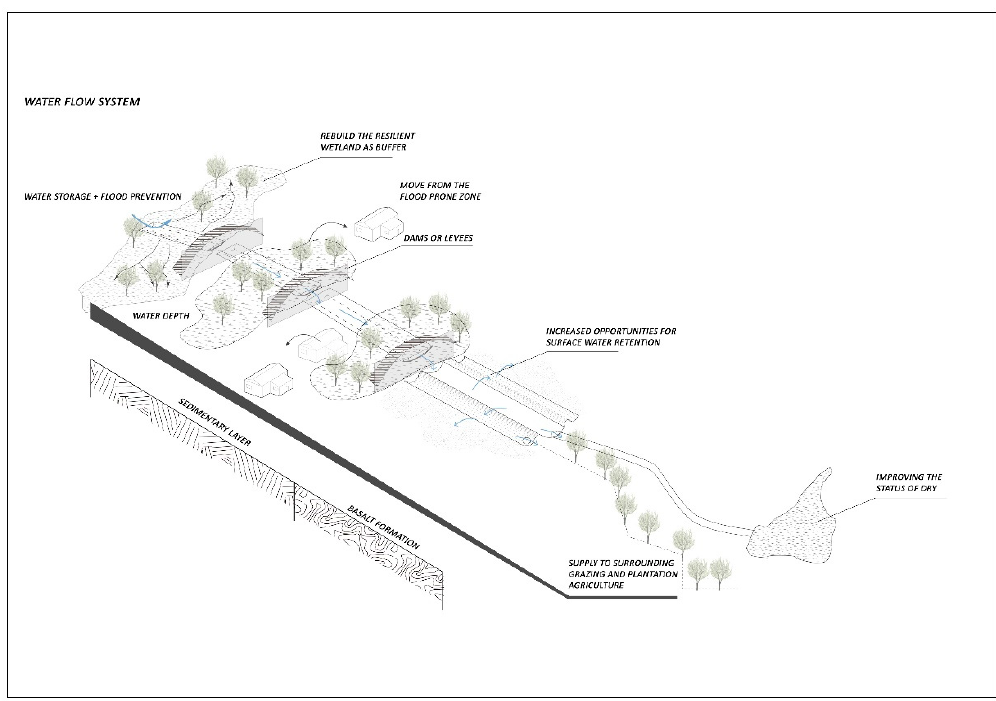
Figure 9. The model of hierarchical dams and their supply pattern.